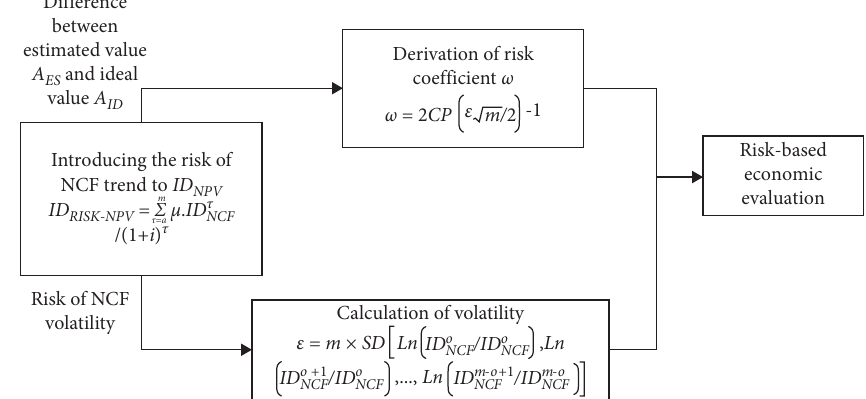
Figure 6: Risk-based economic evaluation procedures of transnational investment projects. Table 1: NCFs of the transnational investment project.